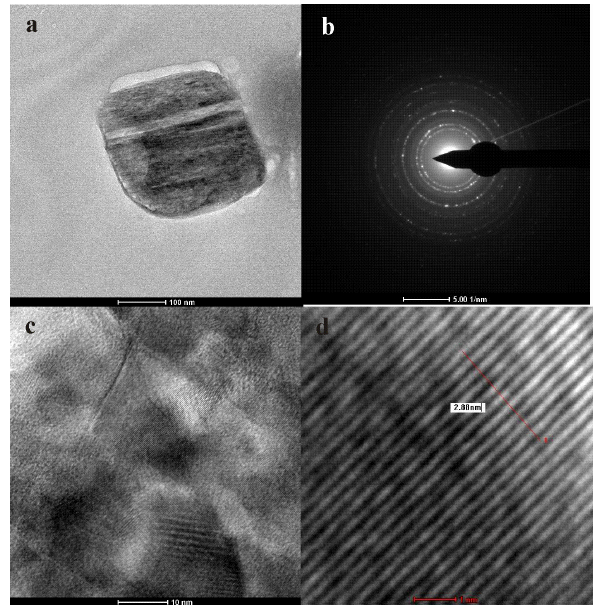
Figure 8. Panel (a) shows the TEM image, (b) SAED pattern, and (c) , (d) HRTEM image of an O-, S-, Ca-, and Mg-containing par- ticle obtained from an ascending gas flow in the soil over Dong- shengmiao deposit.